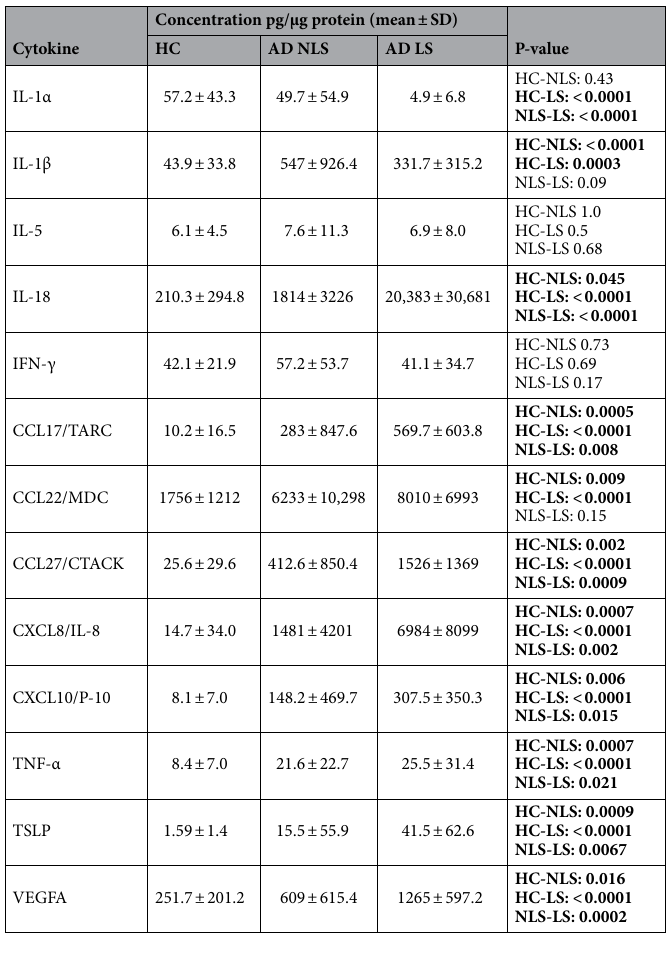
Table 3. Mean cytokine concentration in healthy controls and atopic dermatitis. Bold letters indicate statistical significant p-values. Mean concentration of each cytokine ± standard deviation (SD) within healthy control (HC) skin, atopic dermatitis (AD) non-lesional skin (NLS) and AD lesional skin (LS). Comparison between LS and NLS are made with Wilcoxon test. Comparison between HC and LS, and HC and NLS are made with Kruskal–Wallis and FDR Benjamini–Hochberg